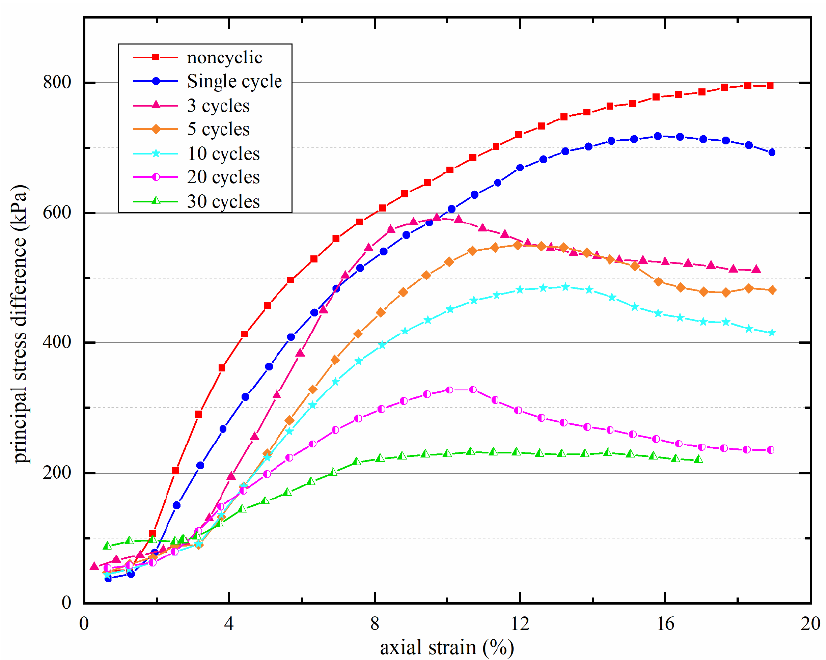
Figure 5. The stress–strain curves of Yili loess samples after varying numbers of drying–wetting cycles.